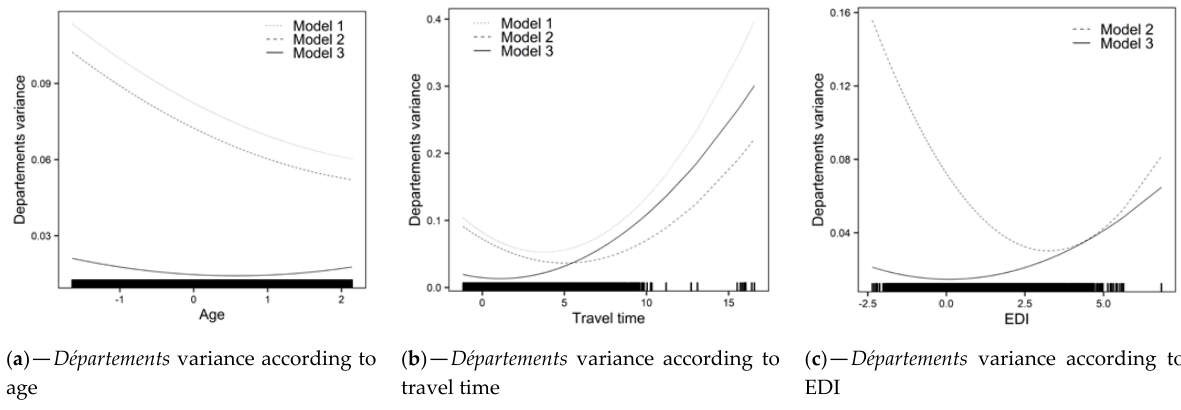
Figure 3. Variance between départements according to lower-level variables. ( a ) Départements variance according to age, ( b ) Départements variance according to travel time, ( c ) Départements variance according to EDI